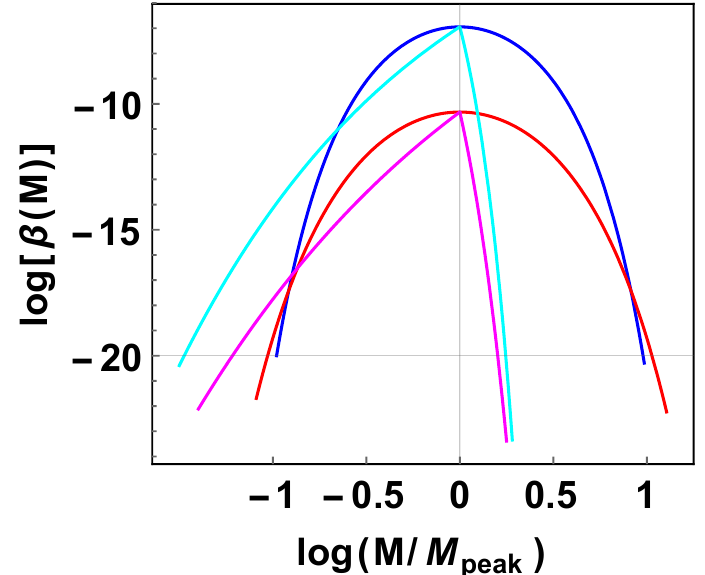
Figure 4. β ( M ) plotted for the Gaussian and Broken power law power spectra given in Equations (45) and (46), respectively. Red and magenta curves are for w = 1/3 for GPS and BPS, respectively. Blue and cyan curves are for w = 1 for GPS and BPS, respectively. P 0 = 0.02 has been used for all the cases presented.